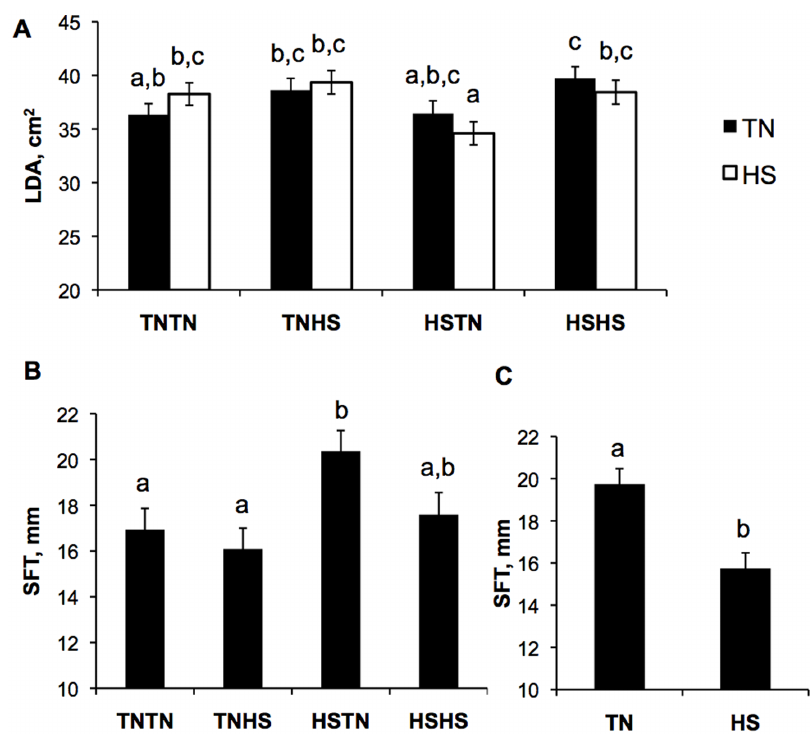
Figure 4. Effects of gestational and chronic postnatal heat stress (HS) on body composition indices following chronic (5 weeks) HS exposure (19 weeks of age). A) An interaction was observed between gestational and postnatal treatments on longissimus dorsi cross-sectional area (LDA) ( P= 0.045), and a tendency was observed for gestational treatment to have an effect on LDA ( P= 0.07). B) HSTN pigs have greater subcutaneous fat thickness (SFT) than TNTN and TNHS pigs while HSHS pigs are not different from other gestational treatments ( P= 0.04). C) Chronic postnatal HS resulted in a reduction in SFT, regardless of gestational treatment ( P= 0.002). Data show the mean 6 SEM of n=6 pigs per postnatal treatment per gestational treatment. Different letters indicate P ,